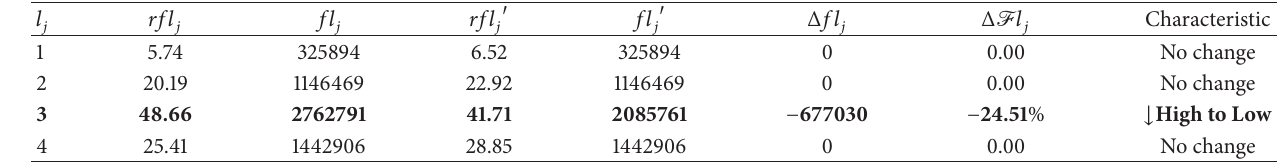
Table 11: Characterization of malicious deletion attacks on length of data values.